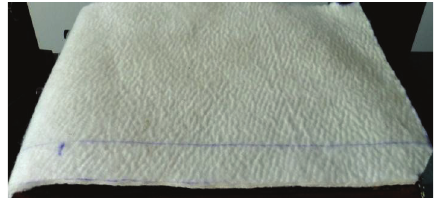
Figure 4: PUR mixed crushed